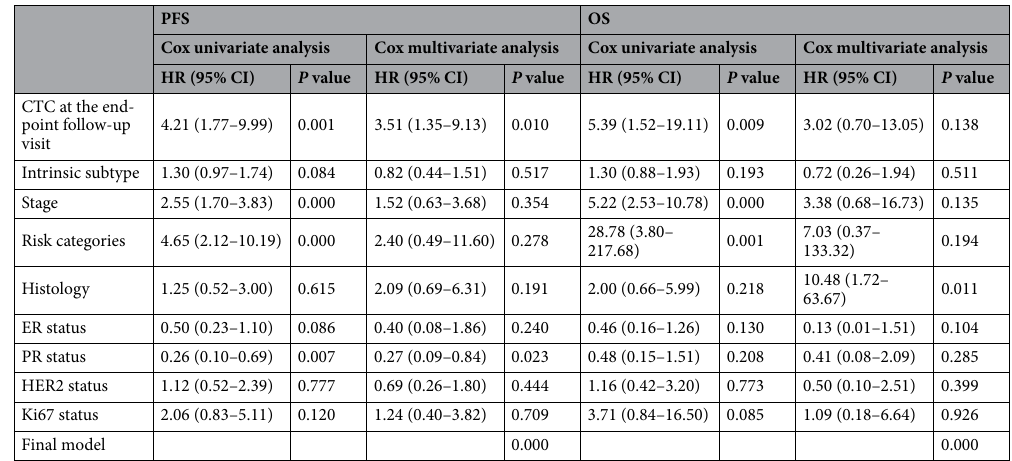
Table 3. Cox univariate analysis and multivariate analysis of CTCs at the end-point follow-up